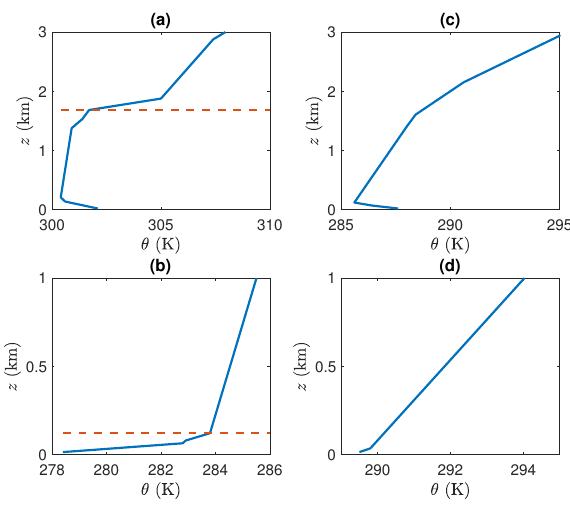
Figure 3. Potential temperature as a function of height for the ( a ) 1200UTC sounding on 12/7/1985, ( b ) 0000UTC sounding on 5/1/1985, ( c ) 1200UTC sounding on 20/1/1985 and ( d ) 0000UTC sounding on 9/1/1985 over Athens. The estimated PBLH using the gradient method is also indicated by the dashed line in ( a , b